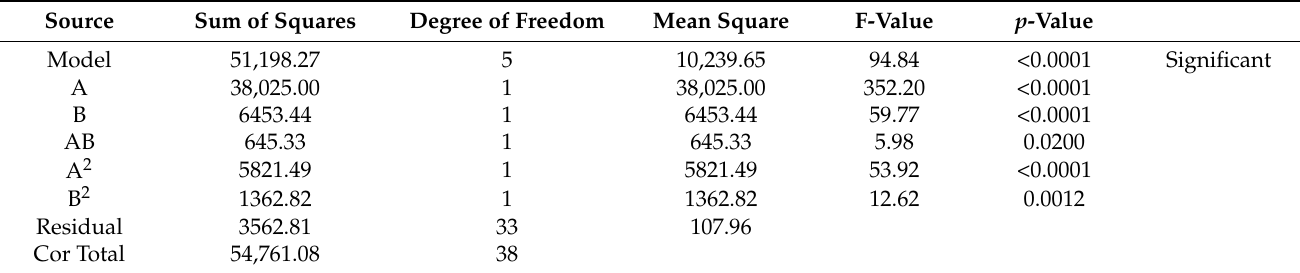
Table 4. ANOVA analysis for TT200.